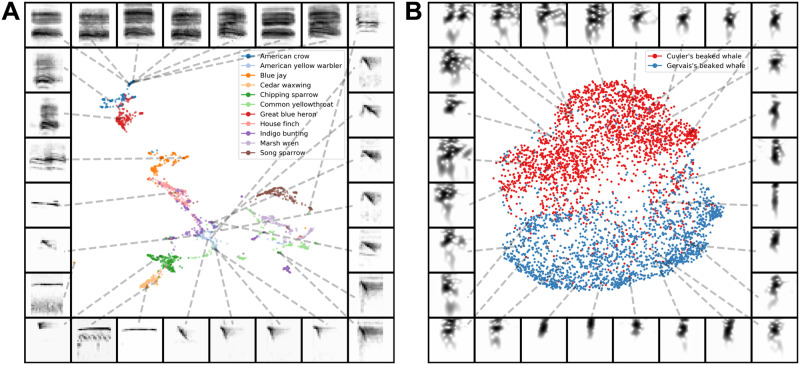
Comparing species with latent projections.(A) Calls from eleven species of North American birds are projected into the same UMAP latent space. (B) Cuvier’s and Gervais’s beaked whale echolocation clicks are projected into UMAP latent space and fall into two discrete clusters.